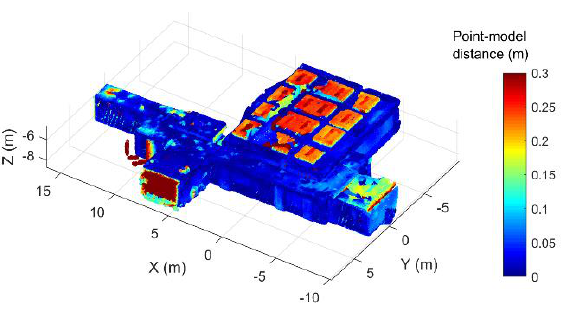
Figure 10. Point-model distances between the Hololens mesh vertices and the 3D